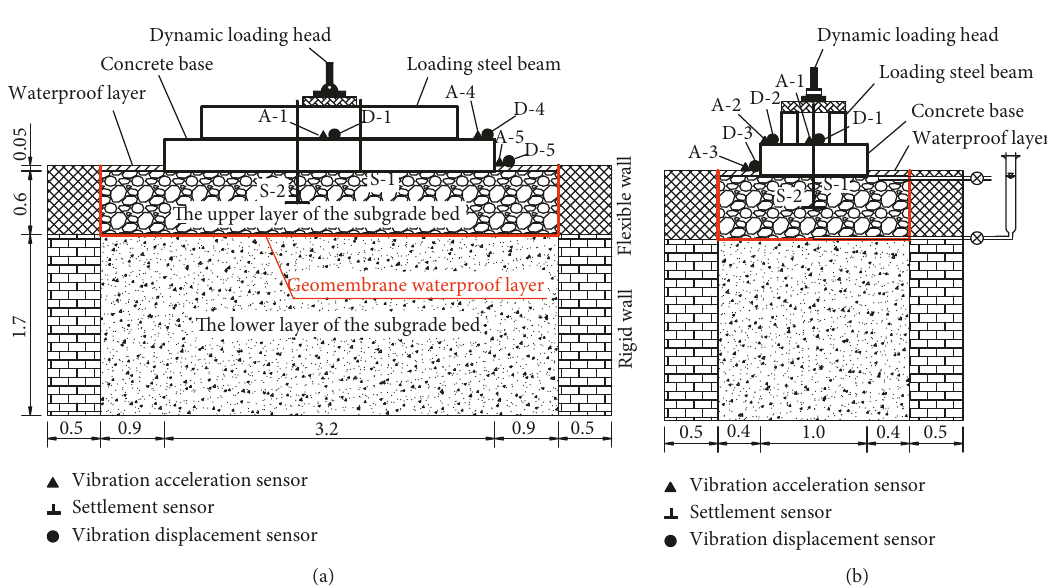
Figure 3: The full-scale model: (a) cross section and (b) longitudinal section profiles (units in meter).